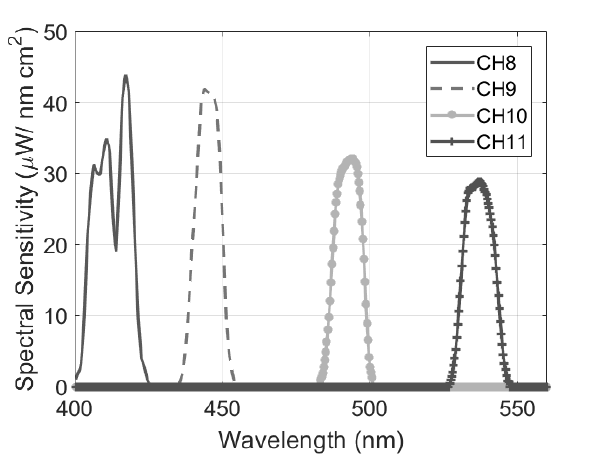
Figure 4. Spectral sensitivity of the MODIS